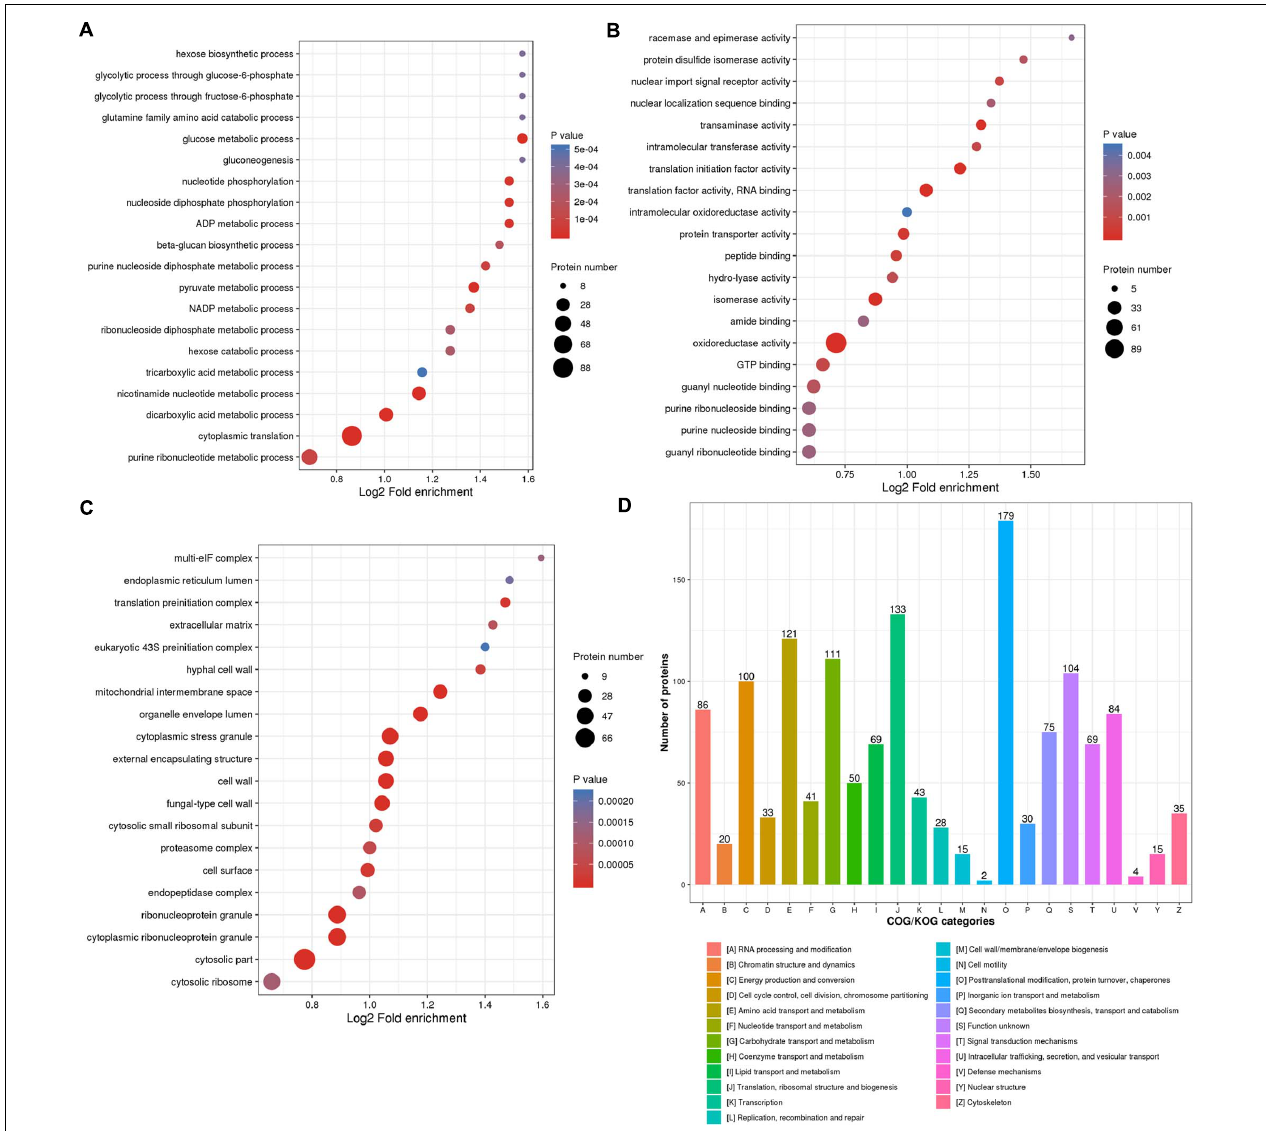
FIGURE 3 | Enrichment categories of the identified thiol proteins. Gene Ontology (GO) classification enrichment bubble plots of the thiol proteins were shown based on (A) biological processes, (B) cellular component, and (C) molecular functions. (D) Clusters of orthologous groups functional classification chart of the thiol